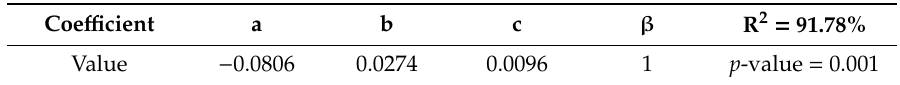
Table 3. Regression parameters of Equation (5) for the Tunnel Traveling Task. (SD(x) [cm]; Speed [cm / s]; ID [bit]).